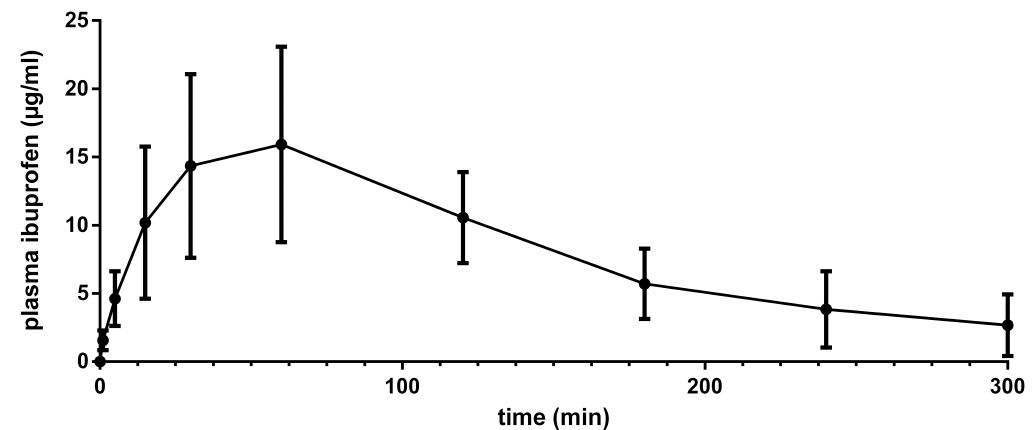
Figure 2. Plasma concentration profiles of ibuprofen as a function of time (mean ± SD for n = 8) for ibuprofen with a dose of 6 mg/kg. Ibuprofen was delivered with nebulized semifluorinated alkanes (SFAs) (F6H8). AUC 0-last was 2489 ± 916 min µ g/mL, C max 17.1 ± 7.4 µ g/mL, and t max 56 ± 30 min.